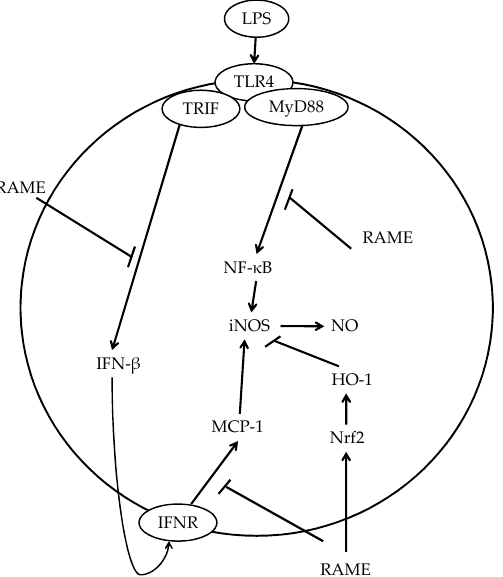
Figure 7. Possible model for the inhibition of iNOS or NO production by RAME in LPS-treated RAW 264.7 cells.